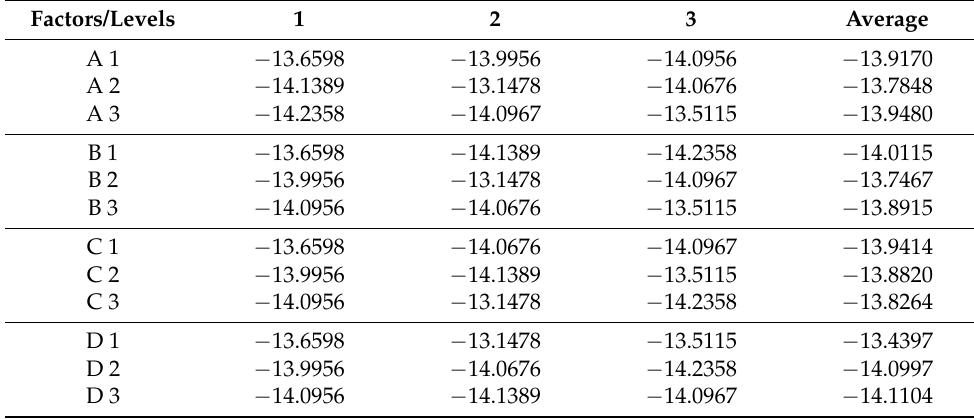
Table 5. Concave S/N ratio for factors/levels.